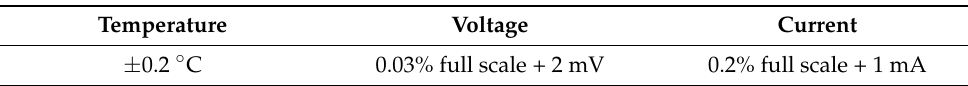
Figure 2. Energy balance at the infinitesimal wall section.